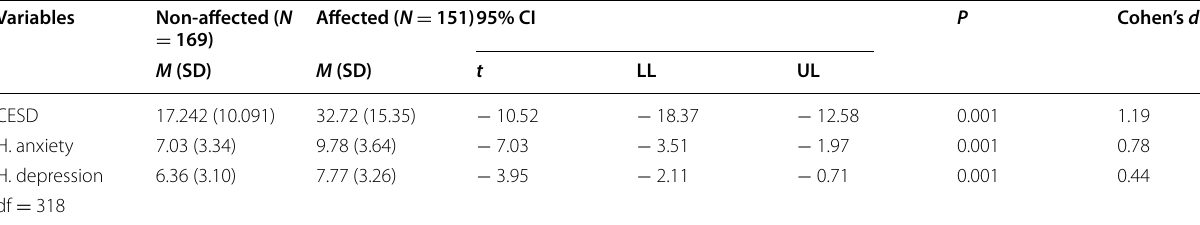
Table 4 Comparison between the affected and non‑affected groups on the Center of Epidemiological Studies Depression Scale and Hospital Anxiety and Depression Scale